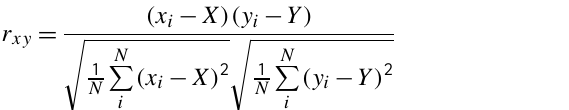
lightning. The correlation coefficient r xy is defined at each point of the grid